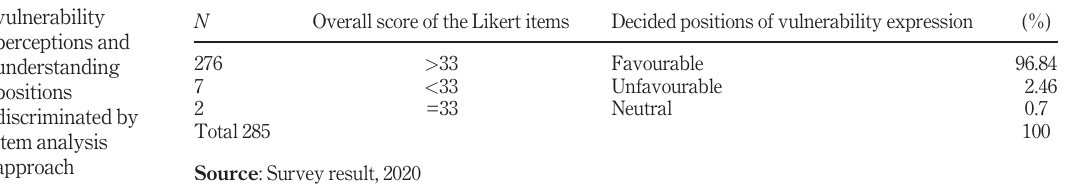
Table 4. Households